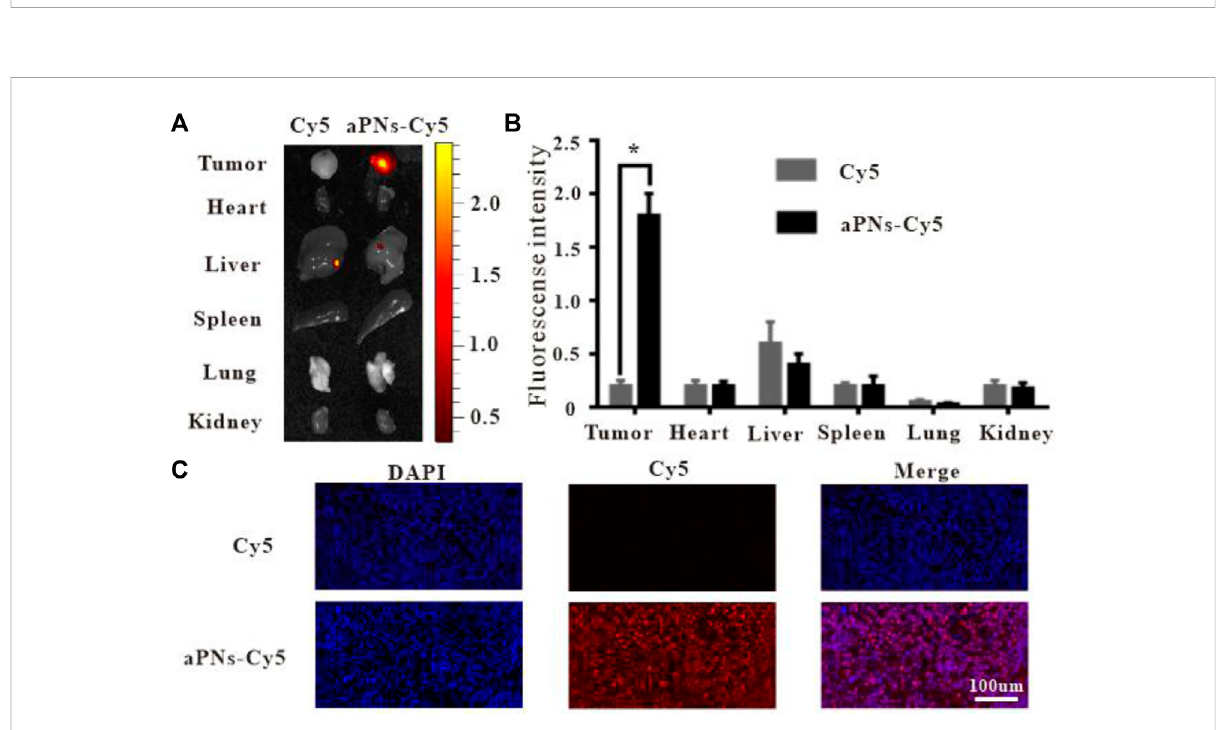
FIGURE 2 In vivo targeting of aPNs. (A) Fluorescence images of internal organs and tumor tissues after treatment with Cy5 and aPNs-Cy5. (B) Semi- quantitative analysis of organ fl uorescent signal, compared with Cy5 group: p p < 0.05. (C) Fluorescent images of tumors from ICR mice at 48 h after injection of Cy5-conjugated aPNs and Cy5, scale bar: 100 μ